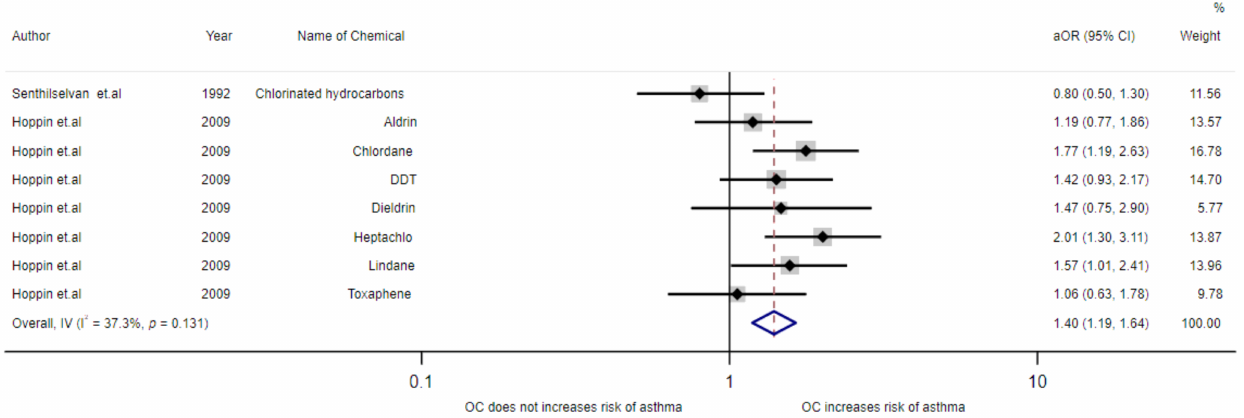
Figure 4. Meta-analysis of exposure to organochlorines and asthma disease.